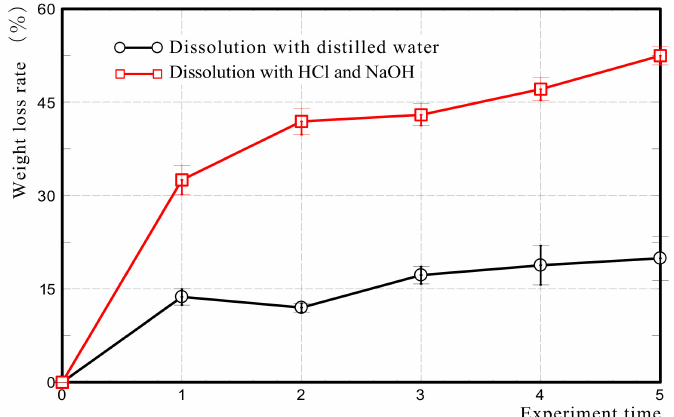
Figure 6. Weight loss rate of Akahoya by the acid–alkali alternate dissolution